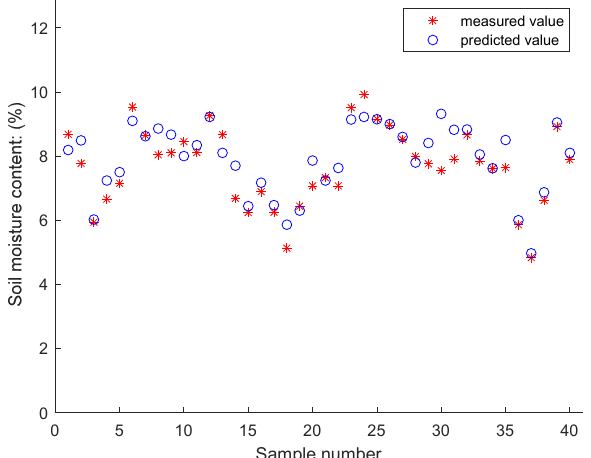
Figure 9. Comparison of predicted and actual values of SMC.